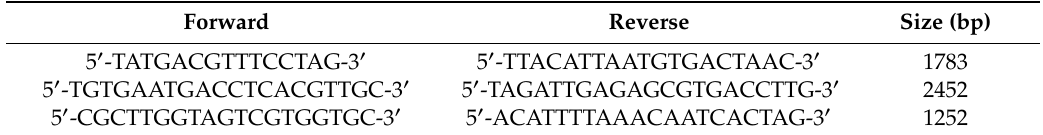
Oligonucleotides used for virus sequencing. PCRs covering di ff erent